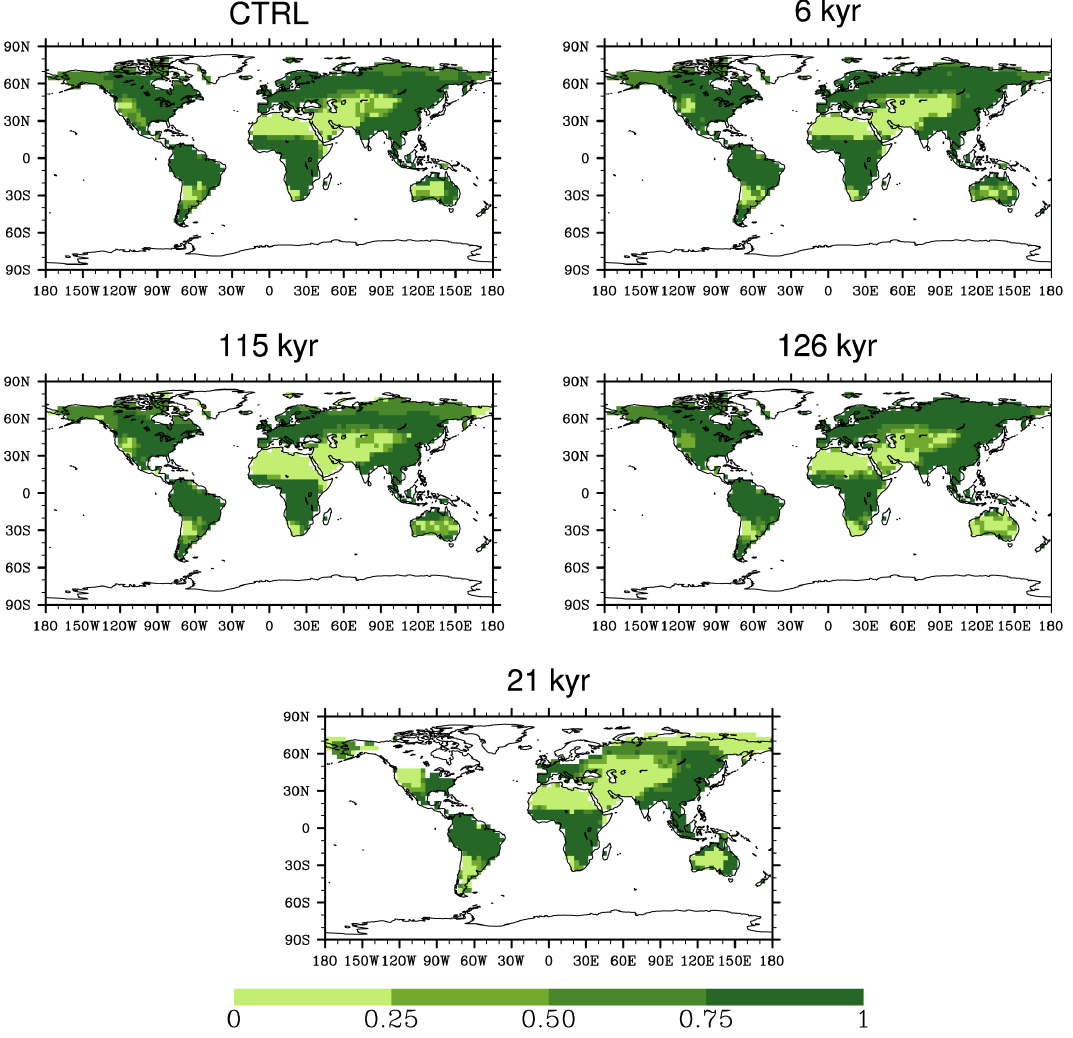
Figure 1. Annual maximum vegetation cover fraction obtained from the LPJ-GUESS model for the CTRL, 6, 115 and 126kyr as well as LGM (21kyr) time periods. The regions with annual maximum vegetation cover less than or equal to 25% (light green) are defined as the potential dust source